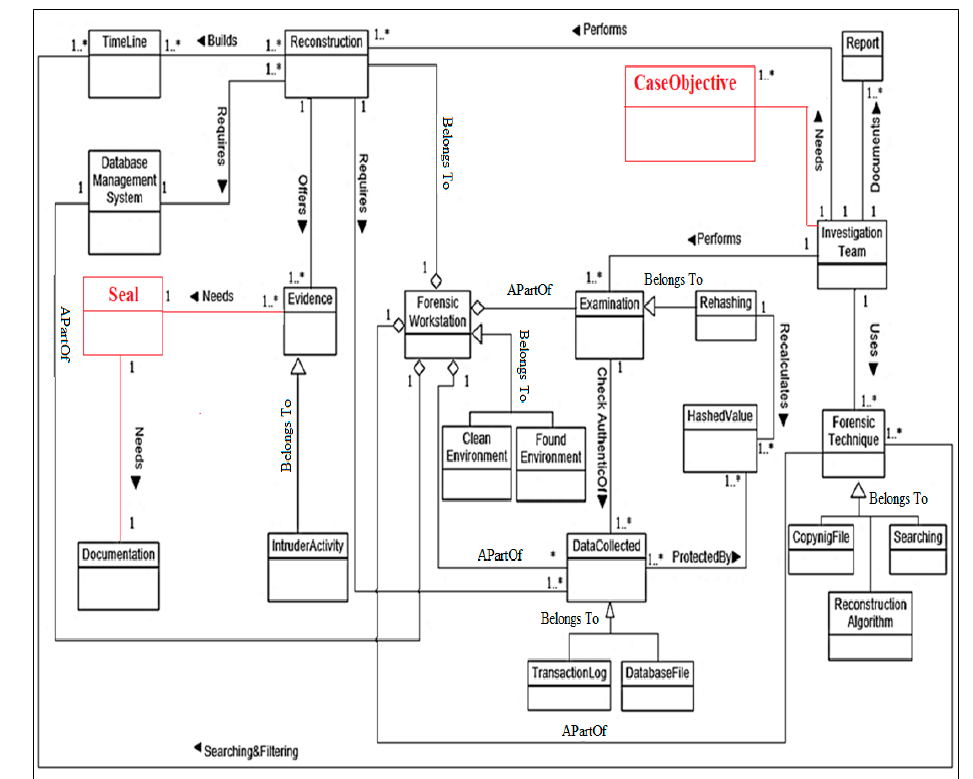
Figure 8. Validated DBFIM Artifact Analysis Class 2.